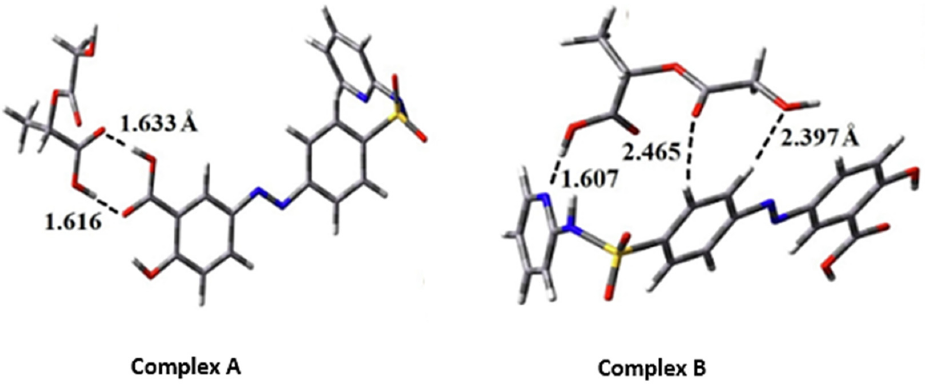
Figure 4. Depicts the two different sulfasalazine and poly(lactic-co-glycolic acid) microparticle configurations. Reproduced with permission from ref. [72]; Copyright 2021, Elsevier Science Ltd.